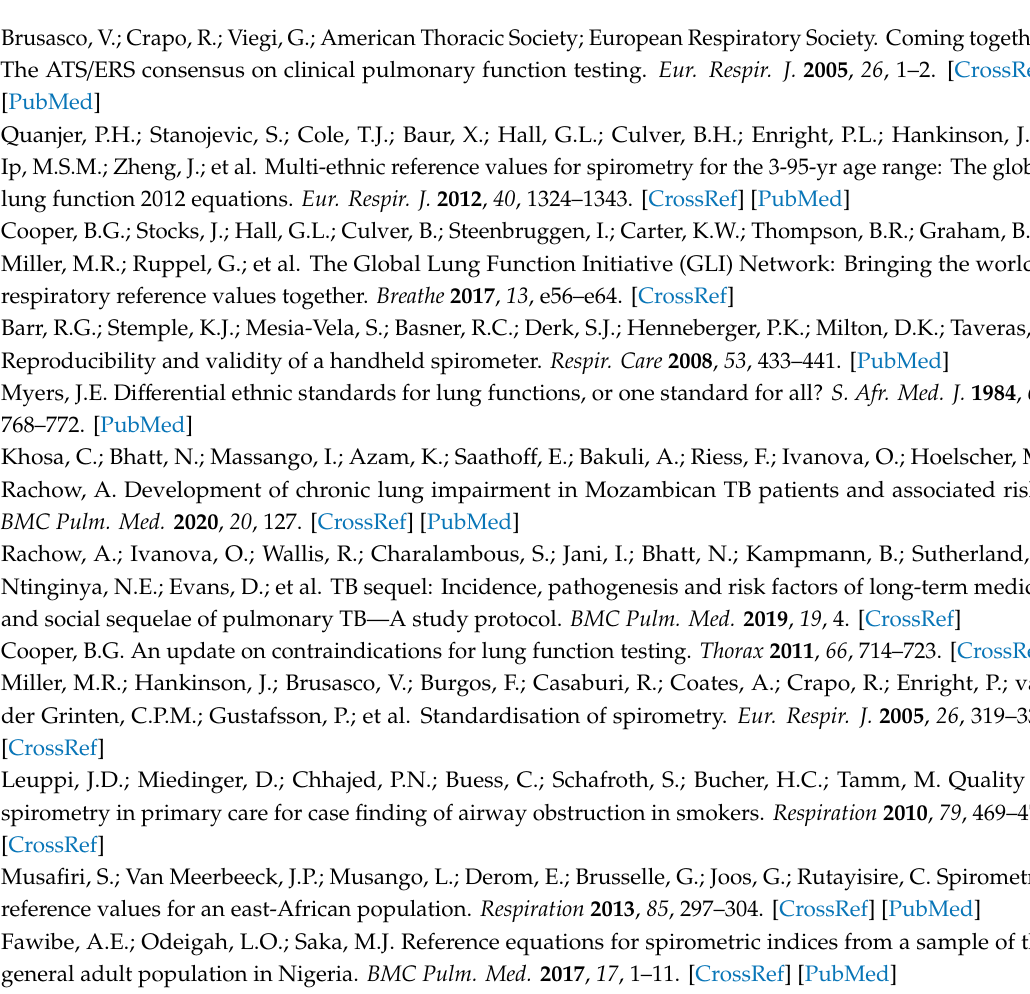
Figure S1: association between the observed spirometry outcomes (FVC and FEV1) according to sex; Figure S2: relationship between the ratio of FEV1 / FVC with age and height; Figure S3: goodness of fit for Mozambican (local) standards predictions and that based on GLI or South African standards when compared to the observed data; Figure S4: di ff erences between z-scores of Mozambican standards and z-scores based on GLI or South African standards; Figure S5: comparison of performance of local Mozambican, GLI and South African standards on a data set of a TB cohort during and after TB treatment from Maputo, Mozambique. Table S1: likelihood ratio test results for selecting the regression model covariates; Table S2: absolute numbers of participants with di ff erent spirometry outcomes and severity grades depending on the applied reference standard (Mozambican, GLI—Others or South African Black prediction equations); Table S3: sensitivity analysis of the prediction equations based on the observed Mozambican data; Table S4: summary from 10,000 non-parametric bootstraps sensitivity analyses on the healthy adult’s data from Mozambique; Table S5: comparison of lung impairment prevalence in the own Mozambican TB cohort using Mozambican, GLI and South African prediction